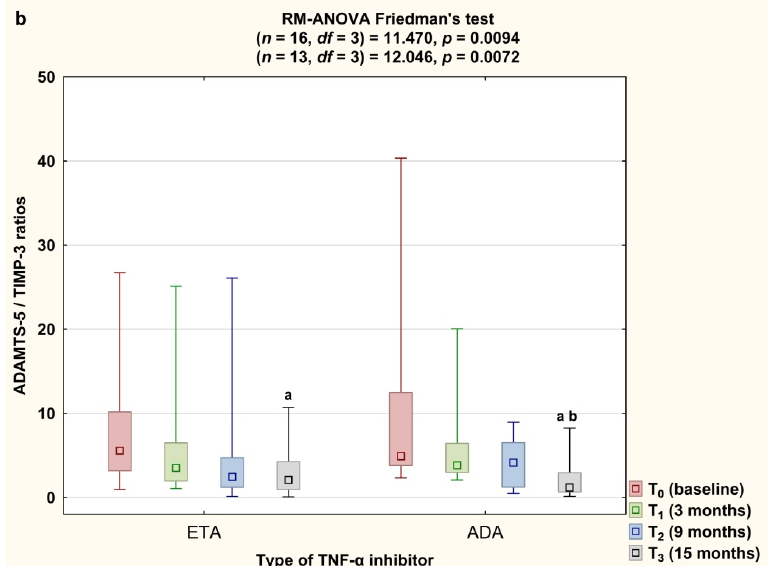
Figure 7. Temporal course of ADAMTS-4 to TIMP-3 ratios ( a ) and ADAMTS-5 to TIMP-3 ratios ( b ) in RA patients during 15-month therapy with either etanercept ( n = 16) or adalimumab ( n = 13). Results expressed as median and interquartile (25th–75th percentile) range and minimum–maximum. Data analyzed using repeated measures analysis of variance (RM-ANOVA) Friedman’s test. Differences noted for all variables considered significant at p < 0.0083 by applying Bonferroni correction.